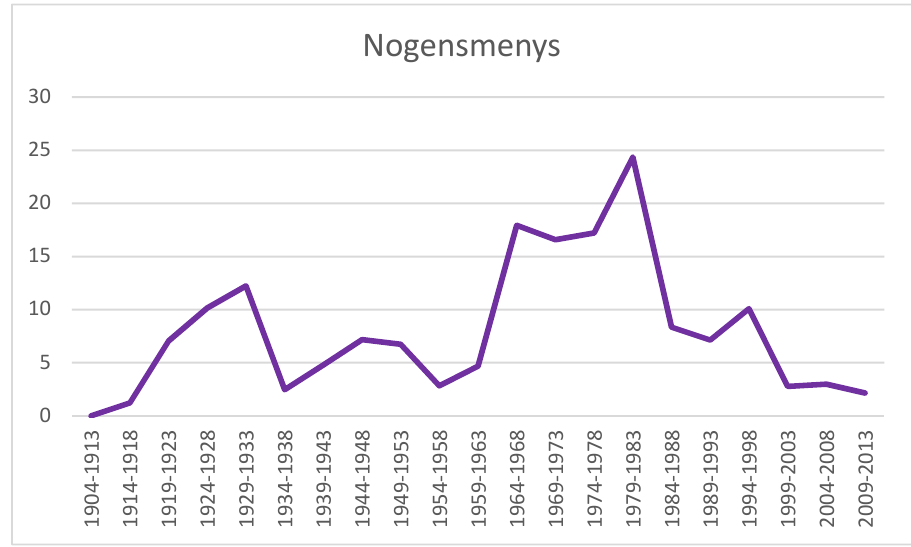
Figure 2. Relative frequency of nogensmenys (normalized per 1 million words).